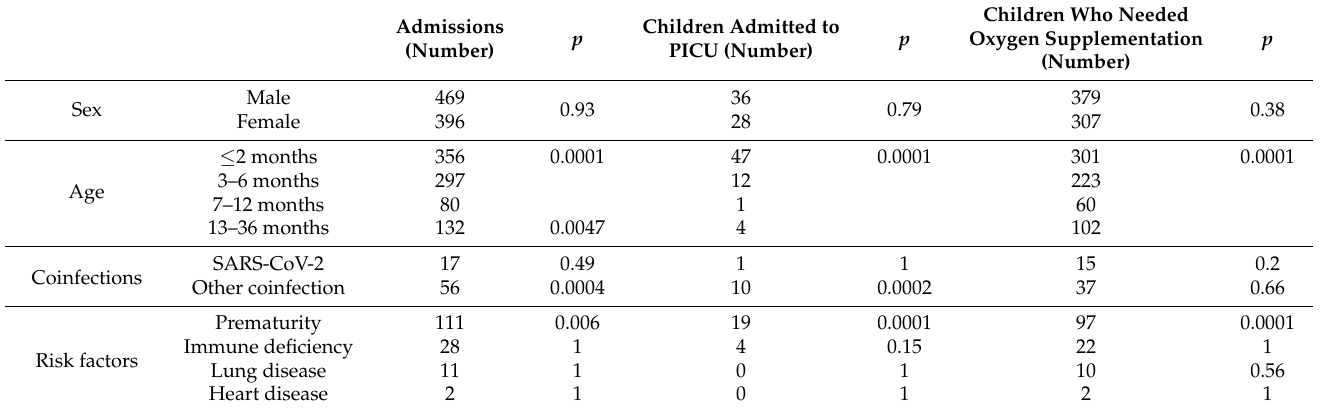
Table 3. Risk factors for hospitalization.